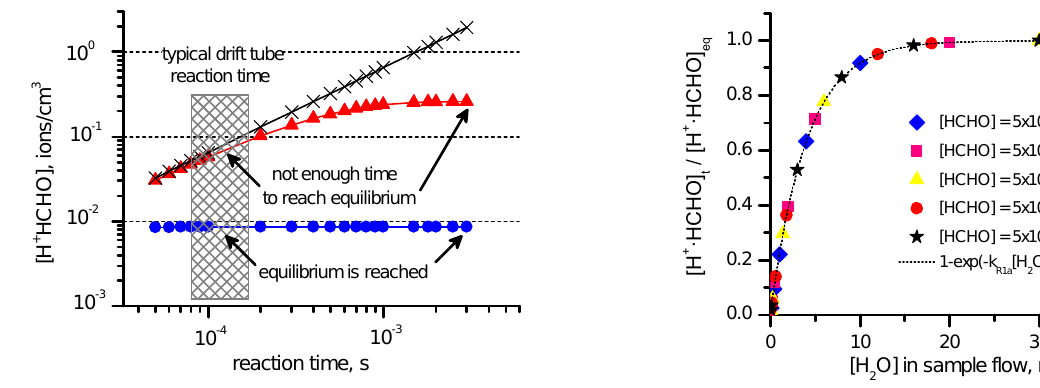
Fig. 2. Calculated concentration of H + · HCHO ions normalized by corresponding equilibrium concentration shown as a function of wa- ter vapor amounts in the sample flow. Dotted line corresponds to the time dependent term in Eq. (2). Symbols correspond to calculations assuming various initial concentrations of HCHO and reagent ion in the drift tube. Reaction time is set to 1 × 10 − 4 s in accord with drift tube reaction. Concentrations indicated in units of molecules cm − 3 and reaction constant k R1a =6 × 10 − 11 cm 3